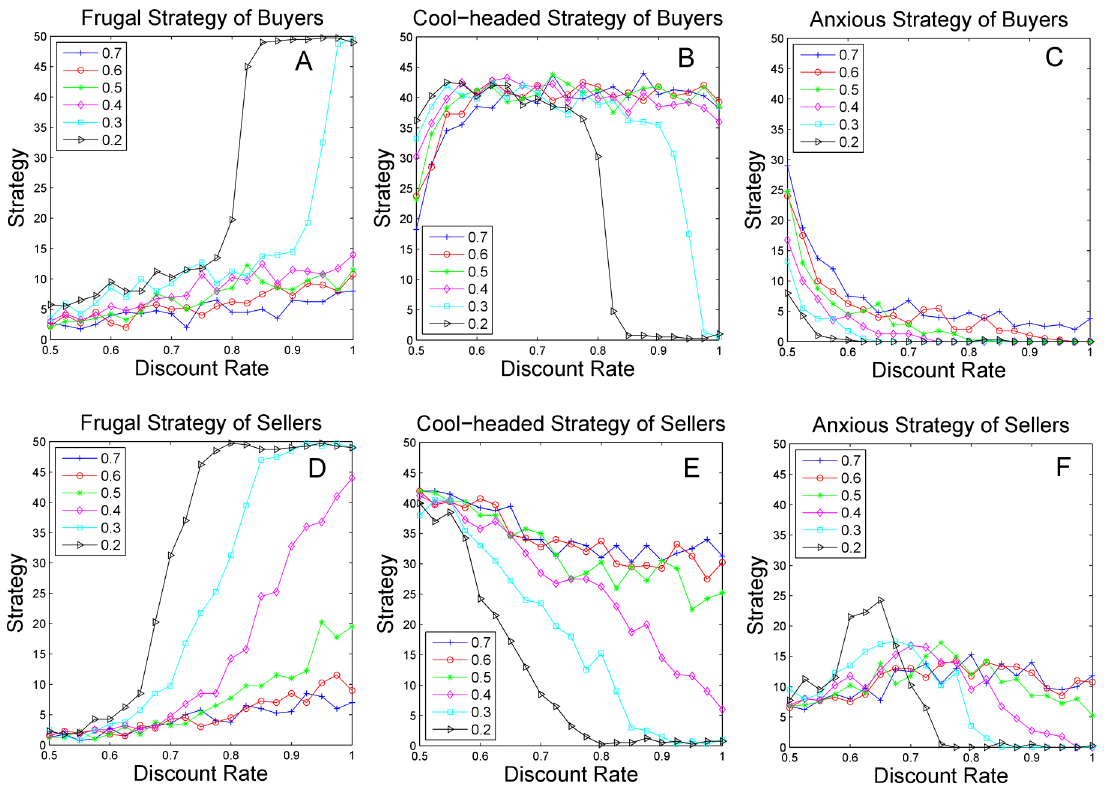
Figure 4. Impact of historical weight on the strategy convergence. Figures 4A, 4B and 4C illustrate the evolution results of the frugal, cool- headed, and anxious strategies of buyers using different weights. The Y axis represents the number of agents using each strategy in the population. Similarly, Figures 4D, 4E and 4F represent the corresponding results for sellers.